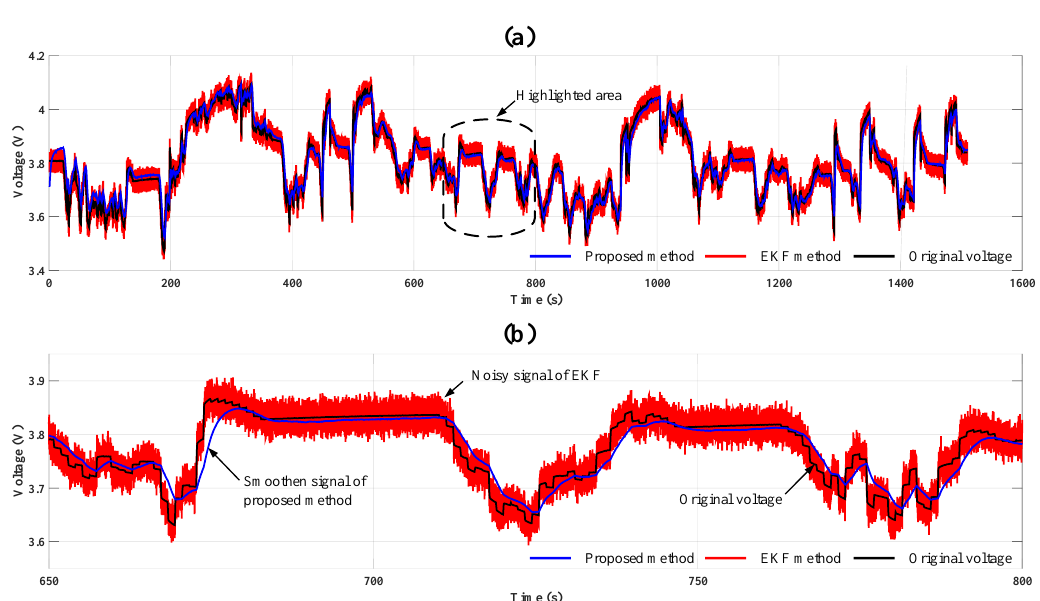
Figure 15. ( a , b ) Estimated voltage of both methods and the original voltage